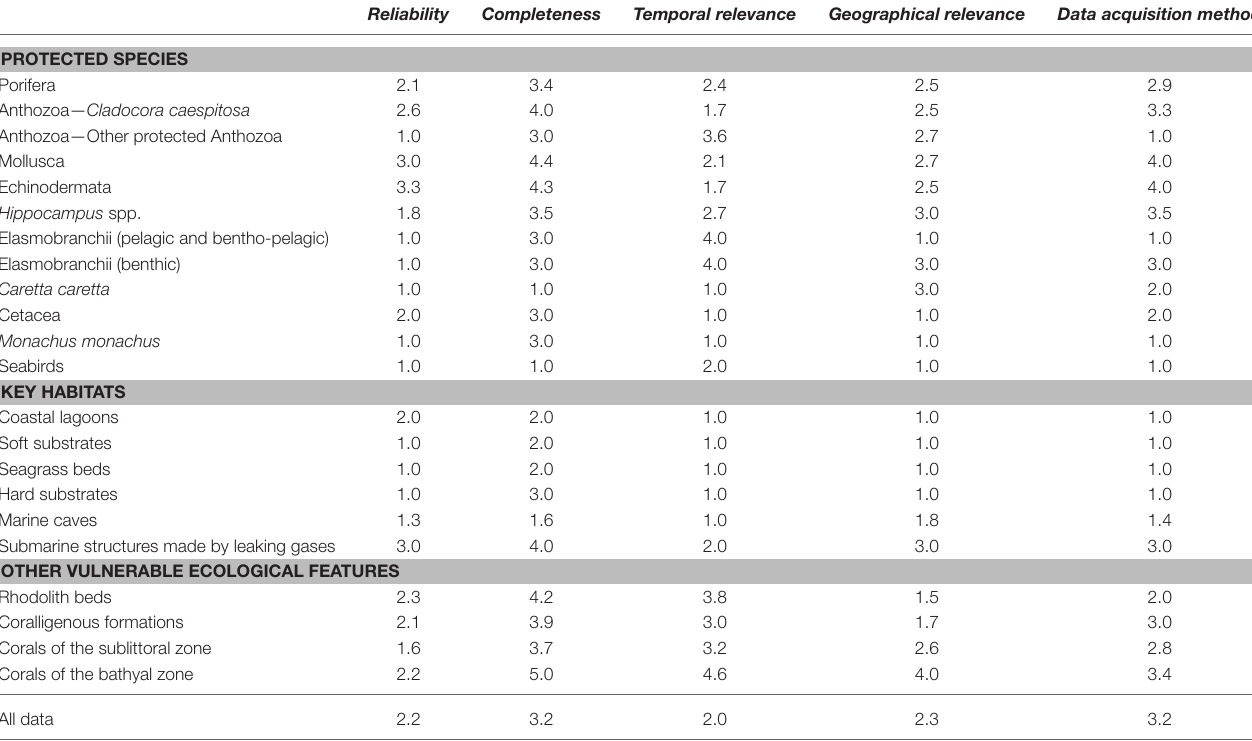
TABLE 4 | Scoring values (weighted averages) of individual ecological features per data quality